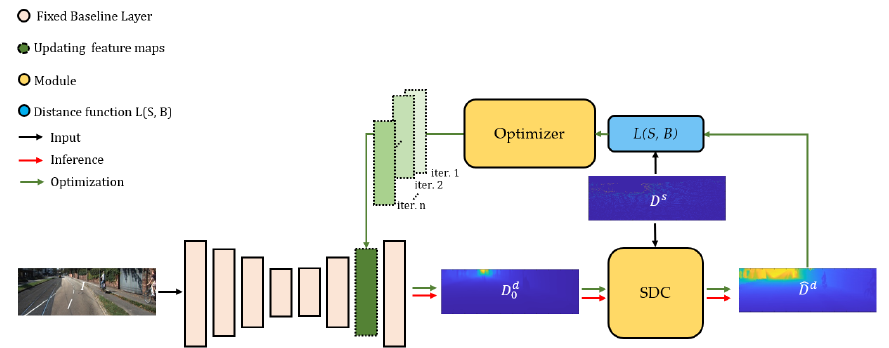
Figure 3. The double-stage adaptive refinement scheme (DARS). DARS refines depth maps estimated by baselines through optimizing (green arrows) an intermediate set of feature maps during inference (red arrows). Hence, given a pretrained baseline with fixed weights and an RGB input image,